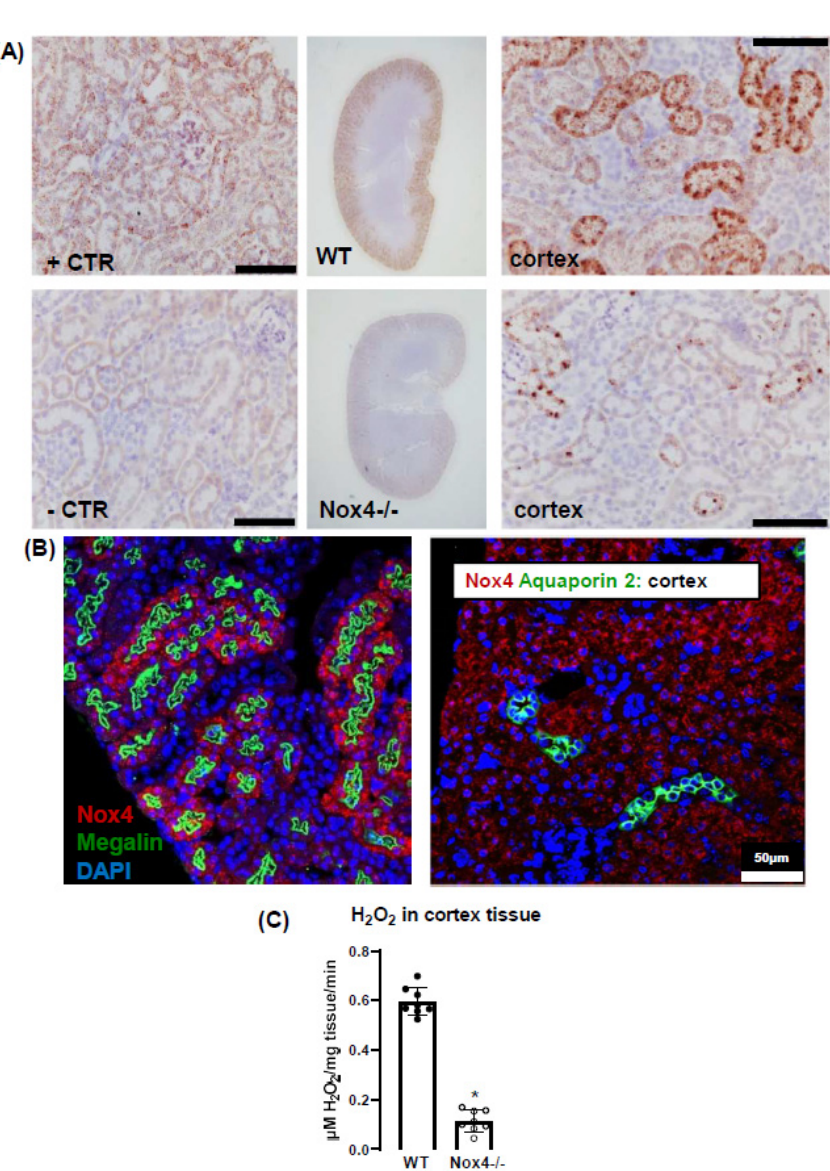
Figure 1. Nox4 is expressed in the proximal tubule cells and produces H 2 O 2 . ( A ): RNAscope in kidney. Left panel: +CTR: peptidylprolyl isomerase B , − CTR: B. subtilis dihydrodipicolinate reductase. Middle: staining of Nox4 in cortex and medulla of WT and Nox4-/- mice. Right panel: higher magnification. Scale bar: 20µm. B: RNAscope combined to IF shows Nox4 expression at the proximal tubule and not at the collecting tubule. C : H 2 O 2 measurement from renal tissue using Amplex red. * p < 0.05. n = 8 mice for each group.